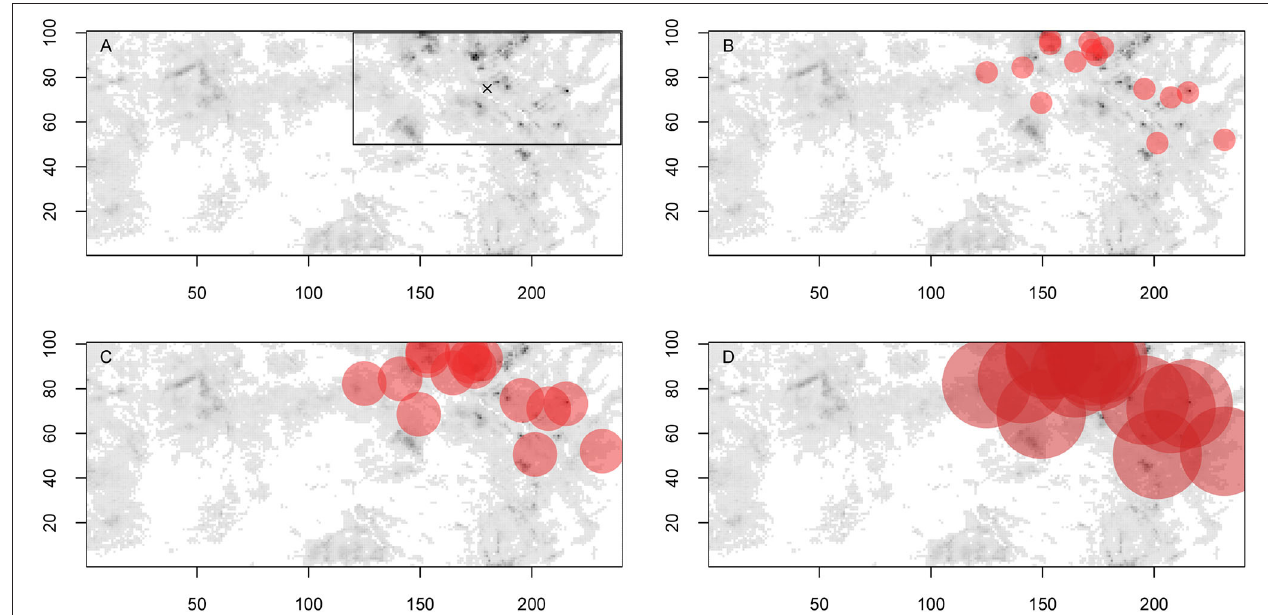
FIGURE 1 | Landscape used in the simulation showing (A) habitat quality and box bounding locations of introduced predators with x marking the forager’s starting location, (B) predators with an encounter radius of 5, (C) predators with an encounter radius of 10, and (D) predators with an encounter radius of